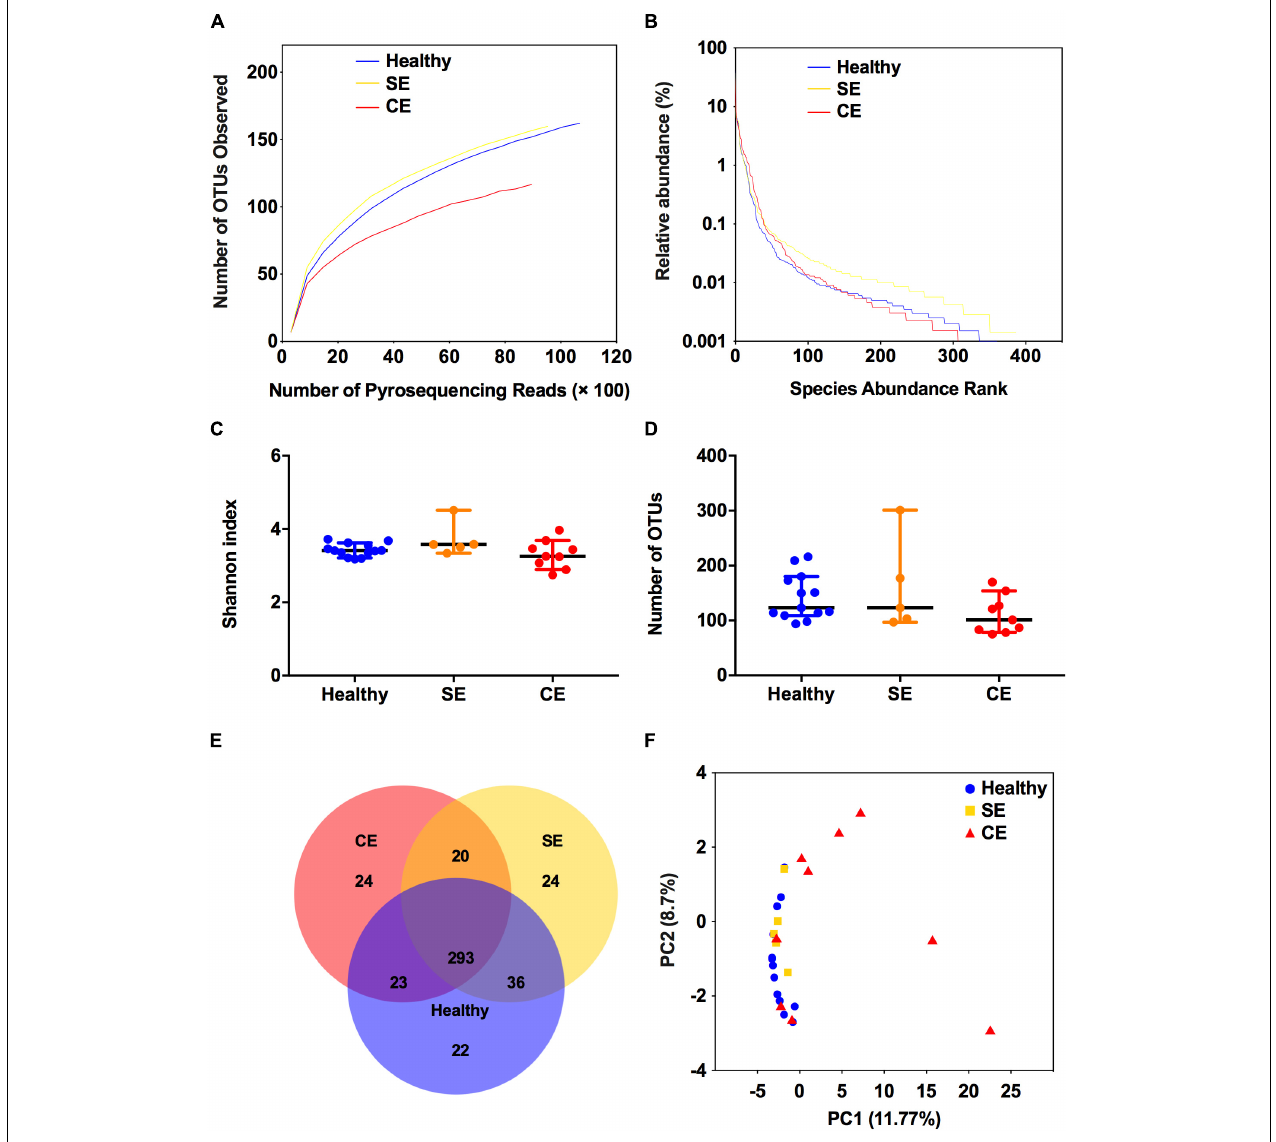
FIGURE 1 | Structural comparison of the uterine microbiota. The rarefaction curves (A) , rank abundance curves (B) , Shannon index (C) , and the number of operational taxonomic units (OTUs) (D) were used to estimate alpha diversity of the uterine microbiota in healthy, SE, and CE cows. Symbols represent data from individual cows, data shown as median with 95% CI. (E) Venn diagram illustrating the common and exclusive OTUs in the uterine microbiota of the three groups. (F) Principal coordinate analysis based on the relative abundance of OTUs with Bray–Curtis distances, showing the differences between each individual cow. Healthy, healthy cows, n = 13; SE, subclinical endometritic cows, n = 5; CE, clinical endometritic cows, n =